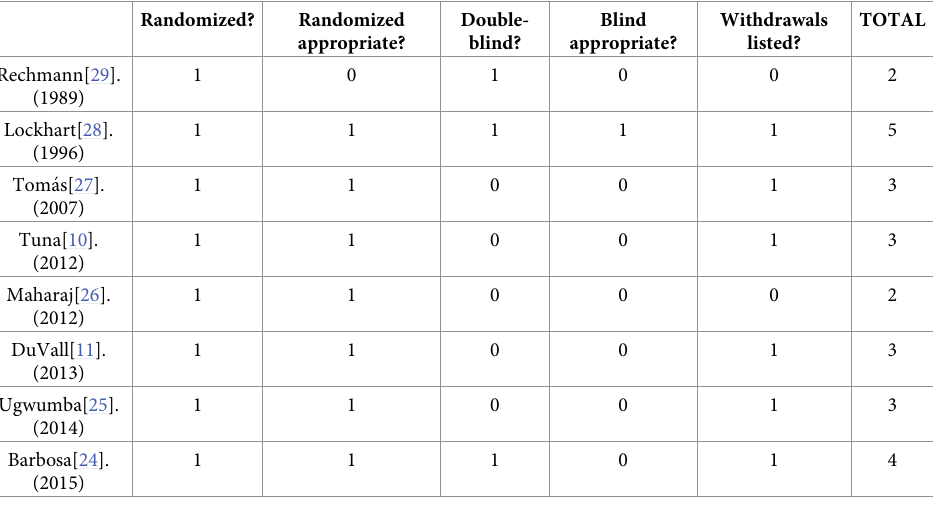
Table 2. Oxford quality